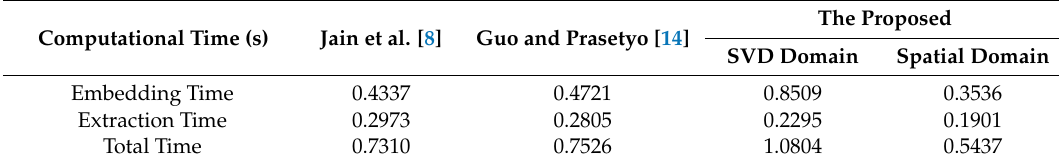
Table 5. Computational time comparisons between the proposed watermarking scheme and other singular value decomposition (SVD) domain watermarking